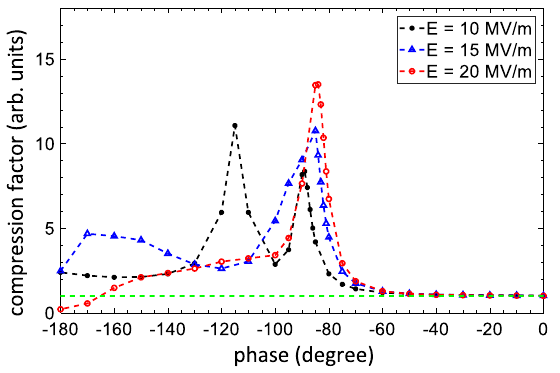
FIG. 2. Compression factor versus the TWA phases under different TWA gradients for single